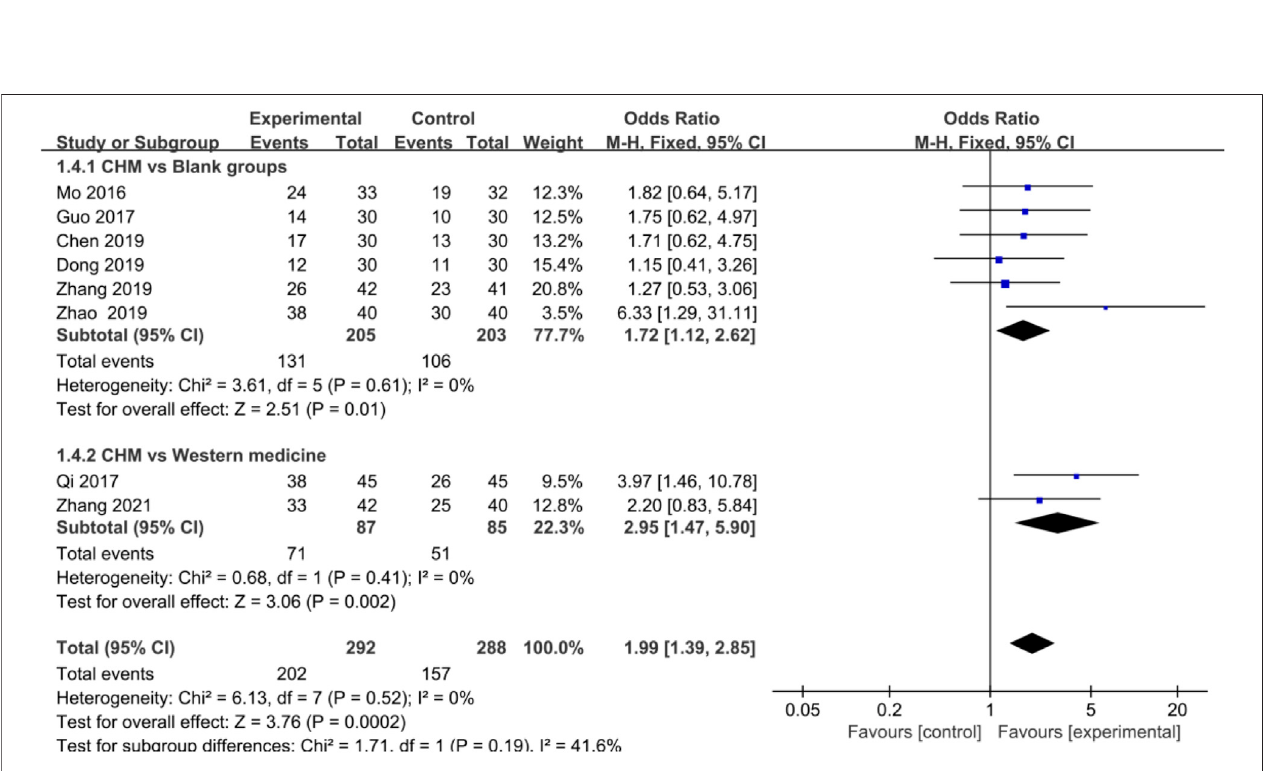
FIGURE 3 | Forest plot: CHM improved ECG in CHD with anxiety compared with control groups.